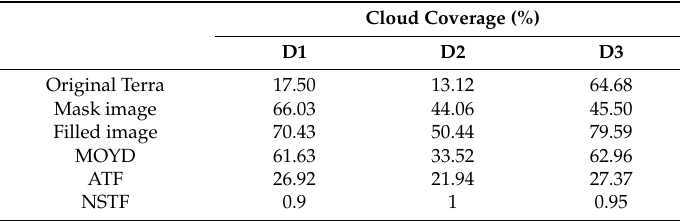
Table 5. Cloud coverage of selected “cloud-free” MODIS Terra SCF images, three extracted mask images, three artificially filled images, and after the implementation of each gap-filling step for a consecutive three-days cloud mask. D1–D3 refers to the selected first to third days.